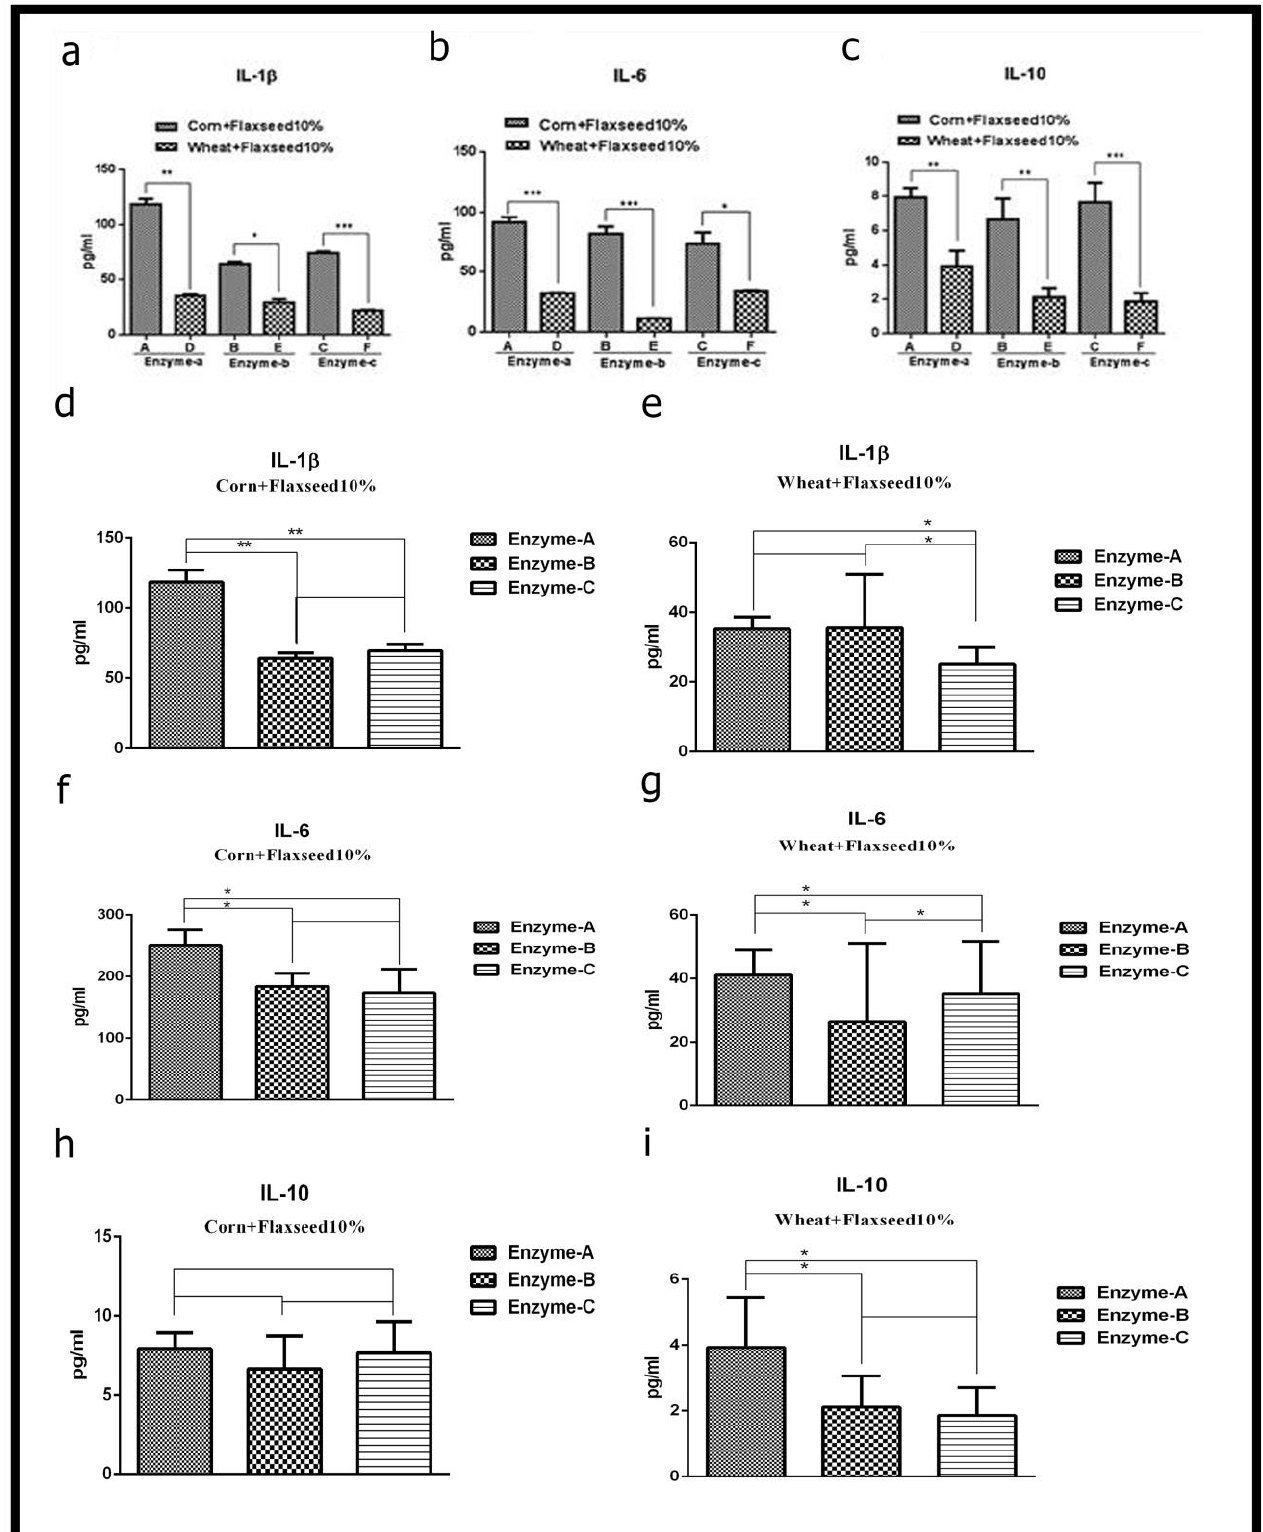
Figure 2. Effect of flaxseed and enzyme supplementation of corn and wheat diet on the induction of cytokines in laying birds. Blood serum samples were collected from laying birds at day 70 after feeding with different diets ( n = 6). The levels of ( a ) IL-1 β ; ( b ) IL-6; ( c ) IL-10 were assessed by using ELISA. The level of cytokines in corn diets and wheat diets IL-1 β , ( d , e ); IL-6 ( f , g ); and IL-10 ( h , i ) with various treatment enzymes (a, b and c). Data are expressed as mean ± SEM.* p < 0.05, ** p < 0.01, *** p < 0.001, and non-significantly.